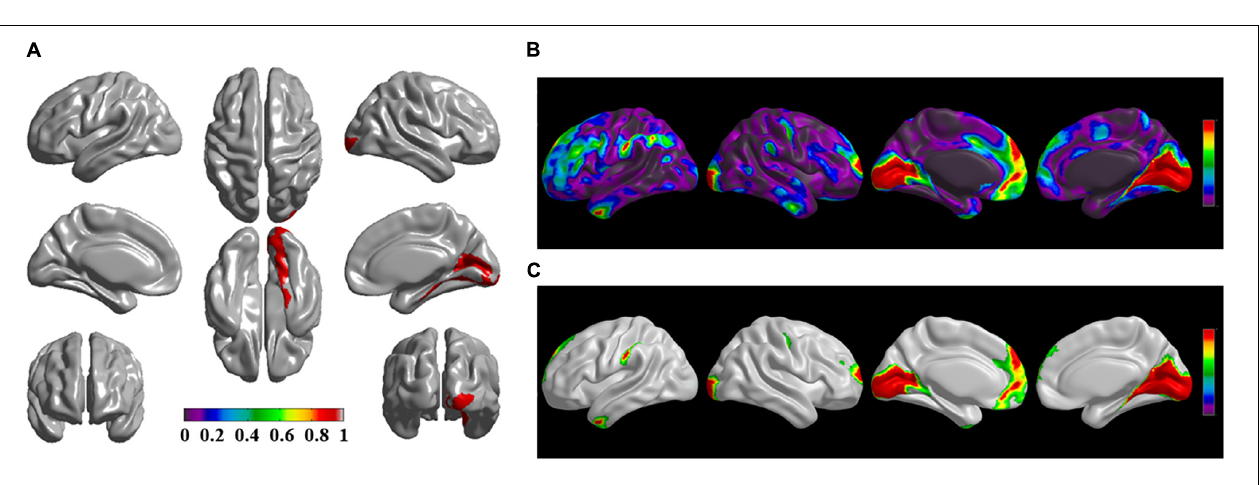
FIGURE 2 | The significantly altered brai n regions of cortical structural connectivity in the sPD brain based on seed 2. (A) The brain regions of seed 2, the red brain regions represent the cortical thickness thinning regions. (B) The significantly altered brain regions in the F-map based on seed 2, the red, and green brain regions represent the brain regions of significant cortical structural connectivity alteration that were not corrected by the FWE. (C) The significantly altered brain regions after FWE correction based on seed 2, the red and green brain regions represent the brain regions of significant cortical structural connectivity alteration that were corrected by the